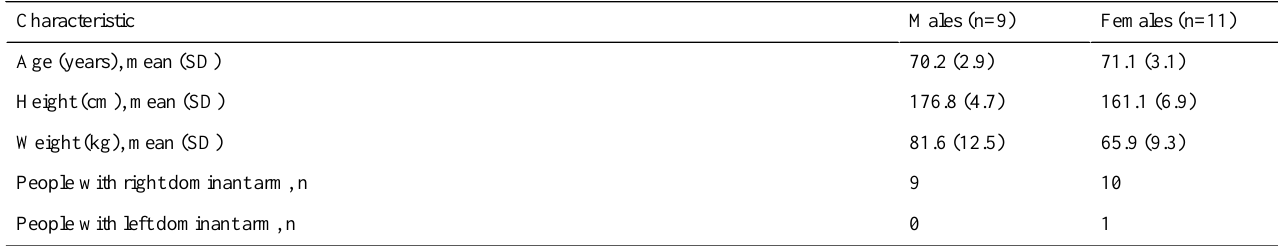
Table 1. Participant characteristics (N=20).